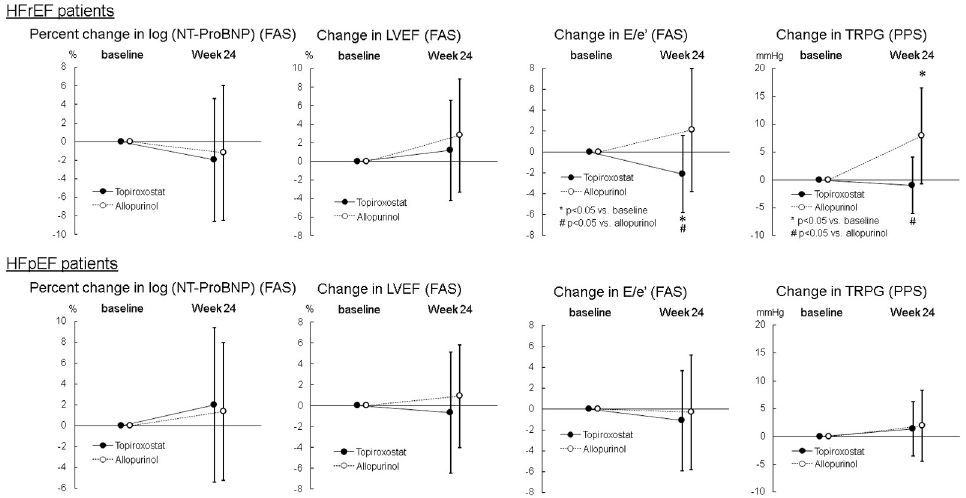
Fig 3. Changes in NT-proBNP, LVEF, E/e’ (FAS), and TRPG (PPS) in each HFrEF and HFpEF patients. Values are mean ± standard deviation. For the changes in the values 24 weeks from baseline were assessed using the paired Student’s t-test in each group. For the difference between both groups analyzed using the unpaired t-test. Abbreviations: HFrEF, heart failure with preserved ejection fraction; HFpEF, heart failure with preserved ejection fraction. https://doi.org/10.1371/journal.pone.0261445.g003 the HFrEF patients, the urinary 8-OHdG level increased significantly in the allopurinol group (2.8 ± 3.1 ng/mg � Cr, P = 0.001), but not in the topiroxostat group (0.4 ± 3.8 ng/mg � Cr) in the FAS analysis. The urinary L-FABP increased significantly in the allopurinol group [0.32 ± 0.57 ln ( μ g/g � Cr), P = 0.024], but not in the topiroxostat group [-0.25 ± 0.65 ln ( μ g/g � Cr)] in the FAS